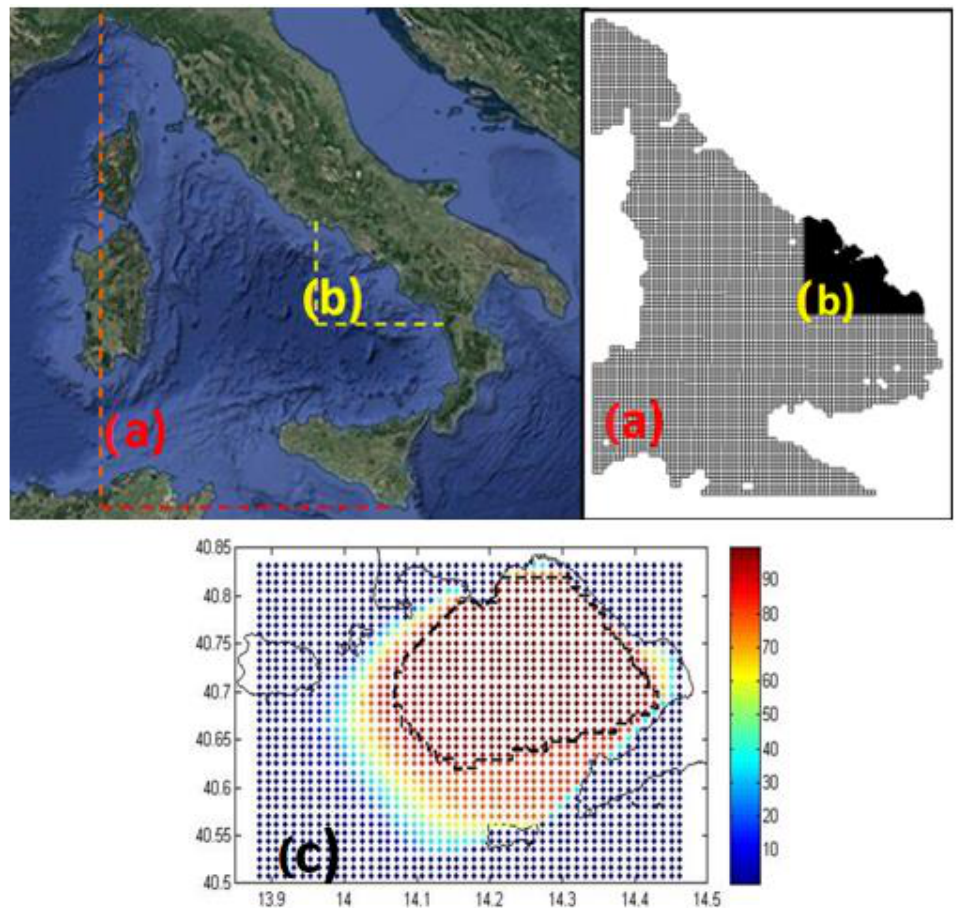
Figure 2. ( a ) ROMS grid covering the whole Tyrrhenian Sea, with a 2 km resolution. ( b ) ROMS finer grid, covering the Campania coast with a 500 m resolution. ( c ) Spatial coverage of CODAR data in the year 2012. The area of CODAR domain characterized by a coverage of at list 90% (black dotted line) is highlighted.